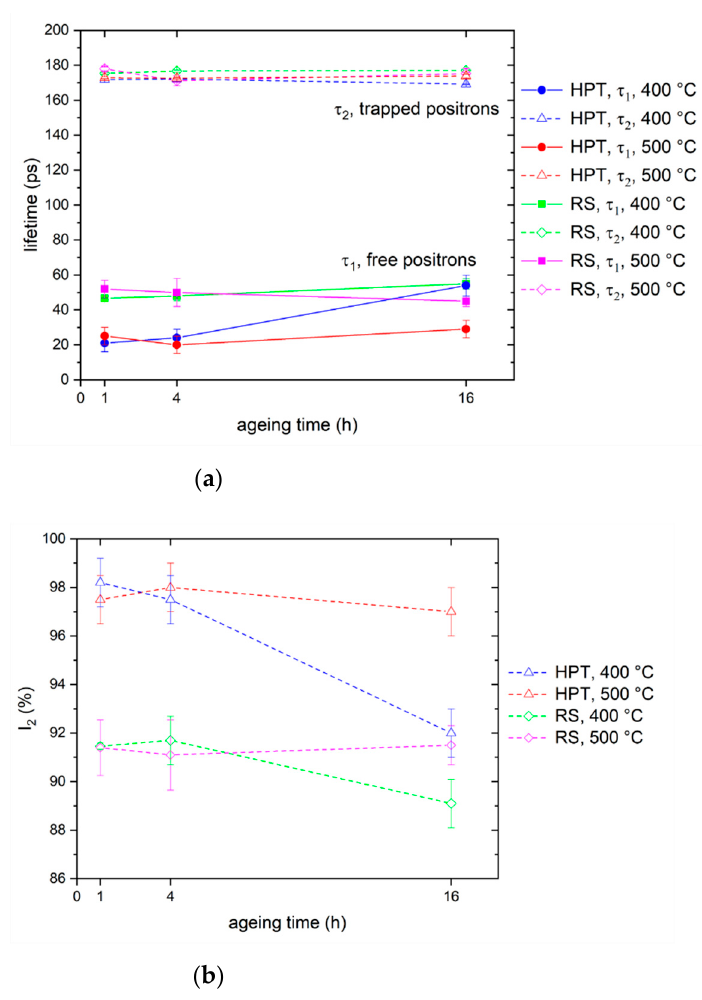
Figure 6. ( a ) Evolution of lifetime of positrons trapped at defects and of positrons annihilated in the free state with ageing time in the HPT and RS samples for ageing temperatures of 400 °C and 500 °C. ( b ) Dependence of the intensity I 2 of positrons trapped at defects in the HPT and RS samples on ageing time for ageing temperatures of 400 °C and 500